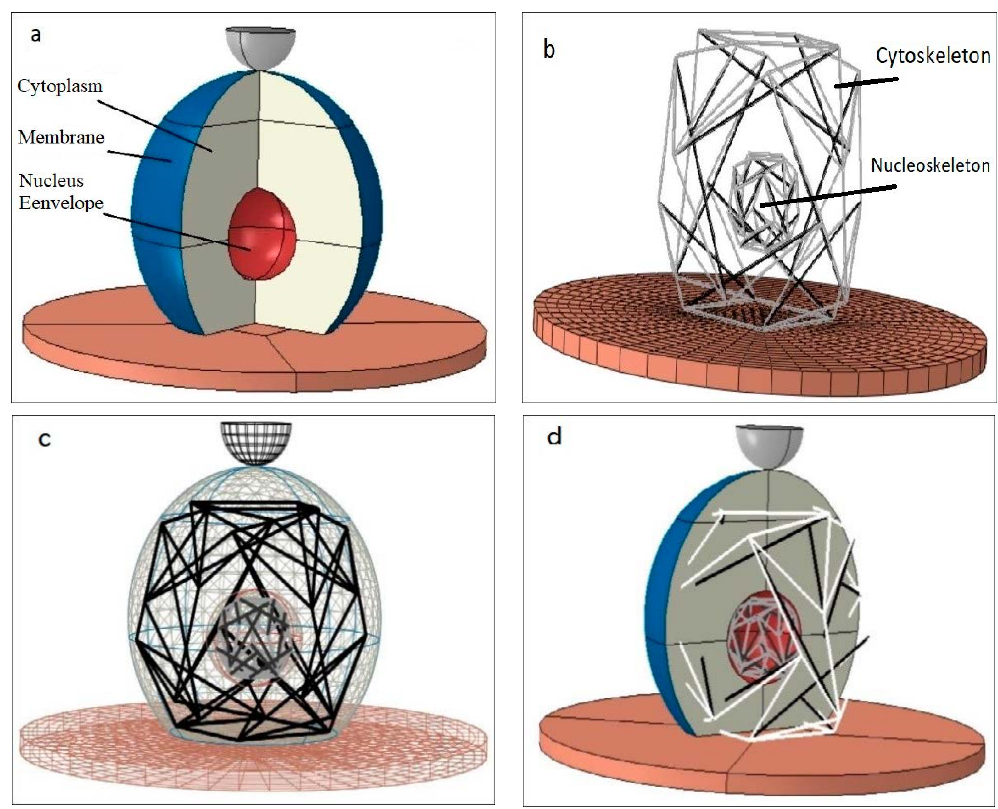
Figure 3. The geometry of the cell model created in Abaqus CAE: ( a ) continuous components including the cytoplasm, membrane, and nuclear envelope merged together, ( b ) two tensegrities, ( c ) meshed complete cell model, ( d ) cut view of the cell model.